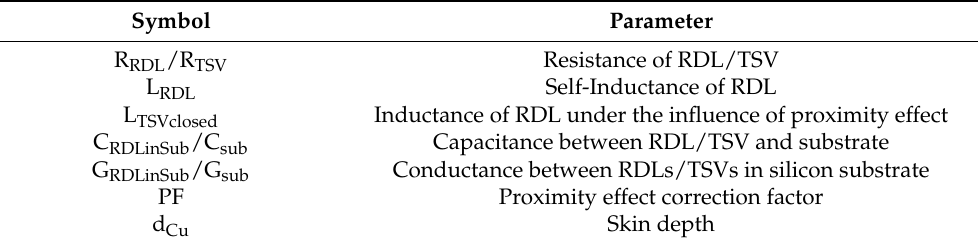
Figure 3. Equivalent circuit models of dual redundant TSV test structure. Table 2. Symbols and parameters in the equivalent circuit model for TSV and